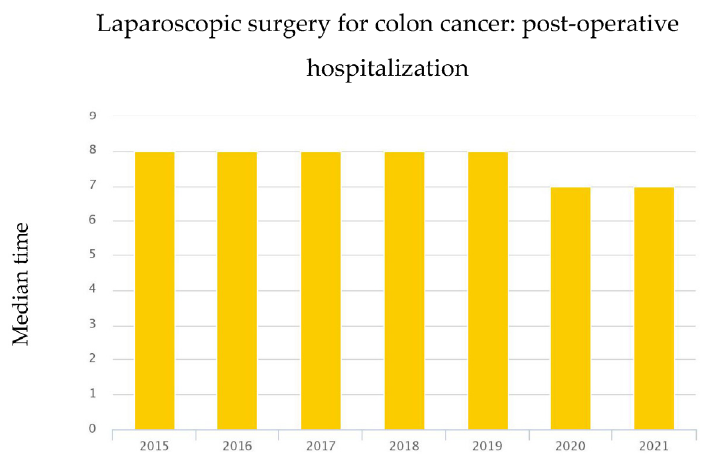
Figure 3. Post-operative hospitalization (median in days) after surgery for colon cancer in Italy according to PNE [11].